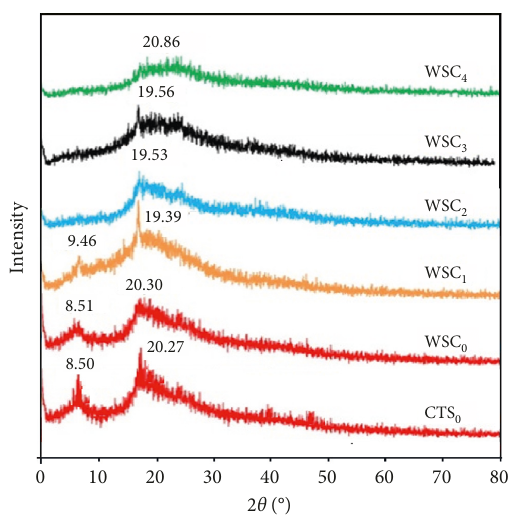
Figure 4: XRD patterns of CTS 0 and the WSC samples. 0 ), only H 2 O 2 -